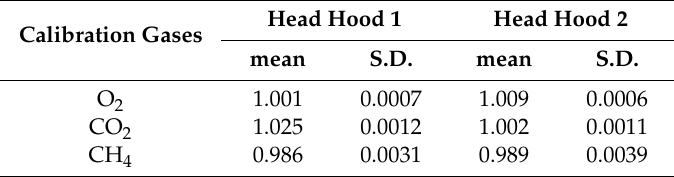
Table 2. Calibration factors (mean and standard deviation; S.D.) of the indirect calorimetry system (n = 6).